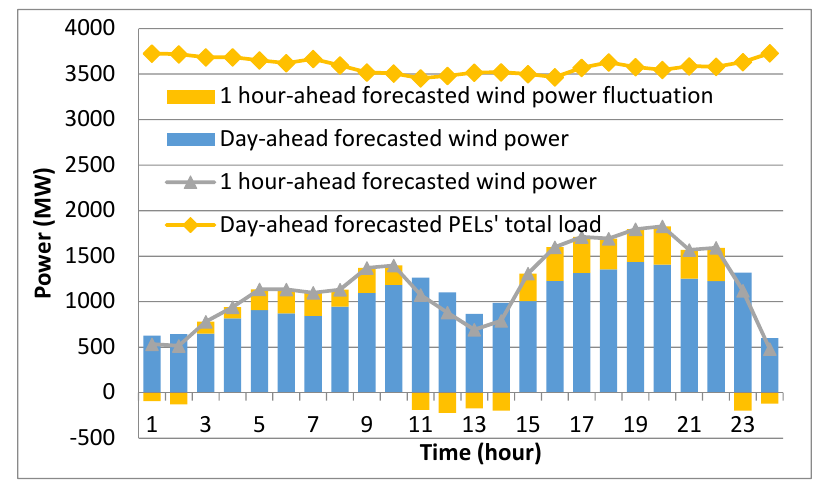
Figure 2. Forecasted Wind Power and PEL